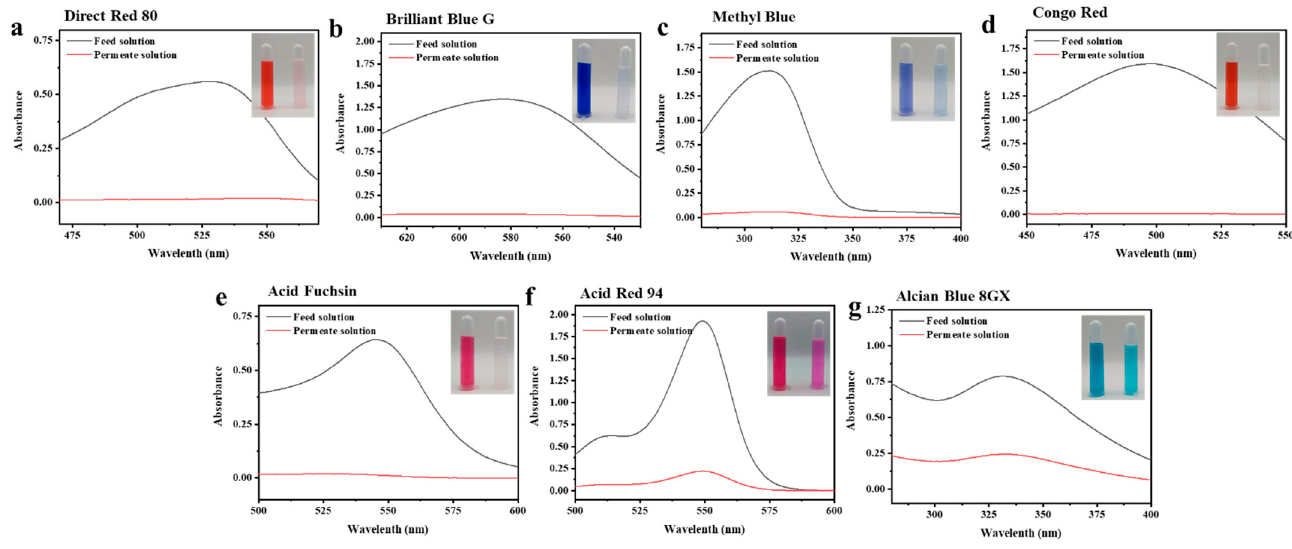
Figure 7. UV − vis absorption changes of an aqueous solution of ( a ) Direct Red 80; ( b ) Brilliant Blue G; ( c ) methyl blue; ( d ) Congo red; ( e ) acid fuchsin; ( f ) acid red; ( g ) Alcian blue 8Gx;.The inserts are comparative photographic images of feed solution (left) and permeate solution (right) of different dyes.